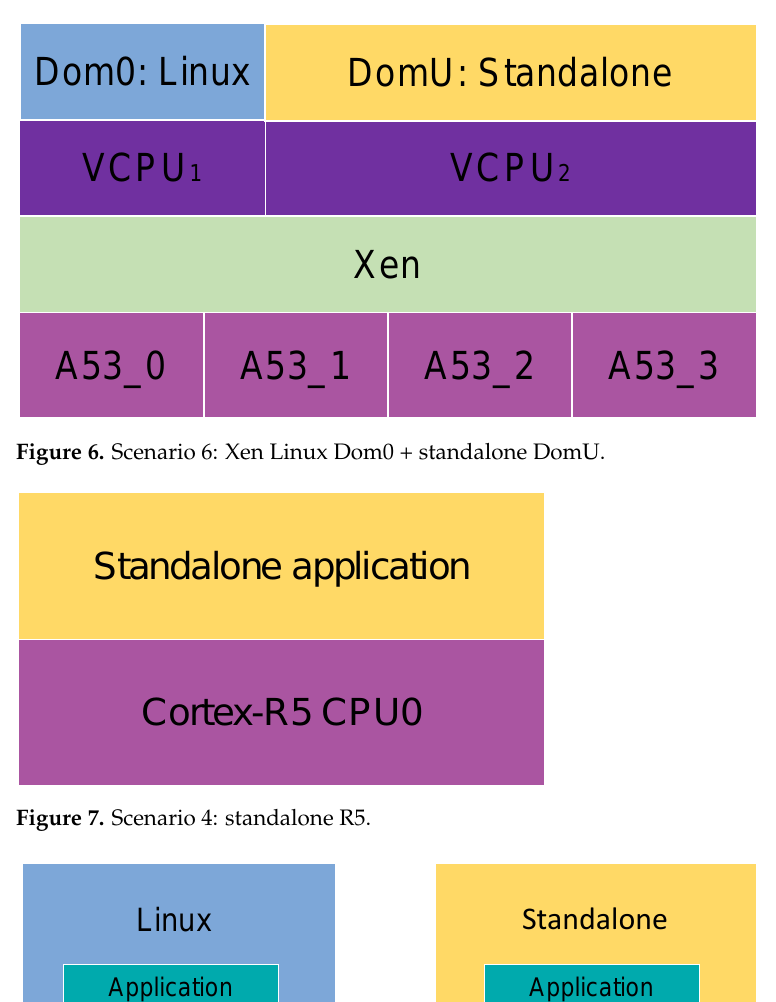
Figure 5. Scenario 3: standalone A53.